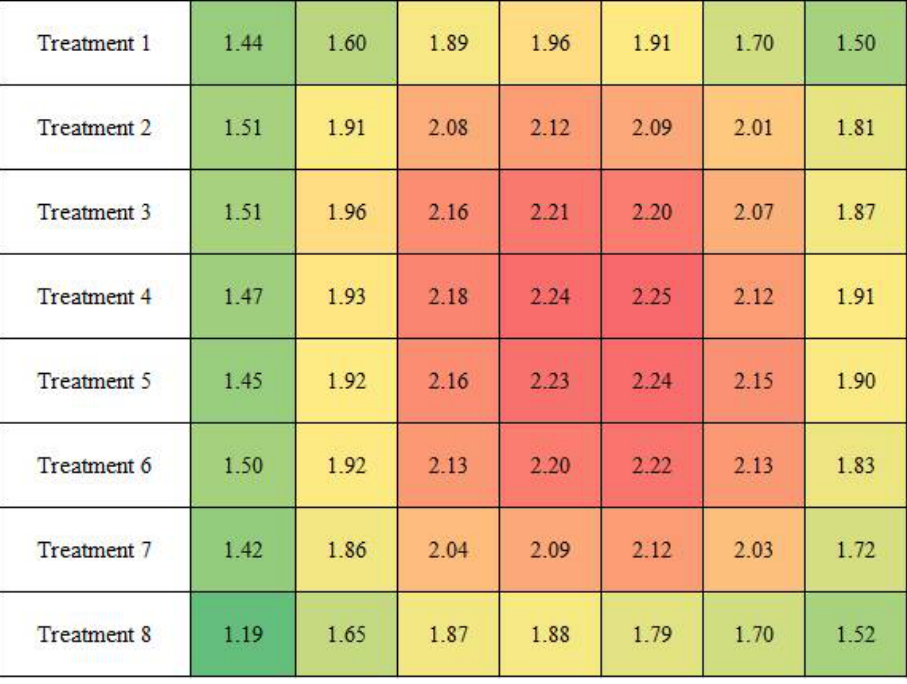
Figure A8. Map of UV light intensity (irradiance) measurements for UV-C (365 nm, LED) for Treatment 1 to Treatment 8. The color gradient green–yellow–red represents increasing UV light intensity. Units: mW/cm 2 .